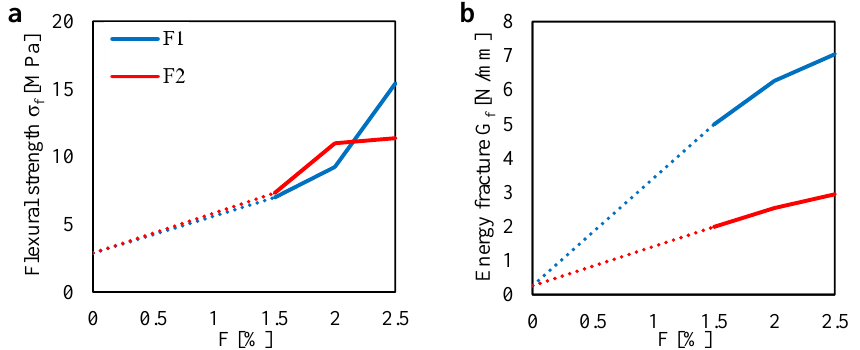
Figure 7. ( a ) flexural strength σ f and ( b ) fracture energy G f measured in the 3PBT for two fiber type (F1 and F2) with different fiber